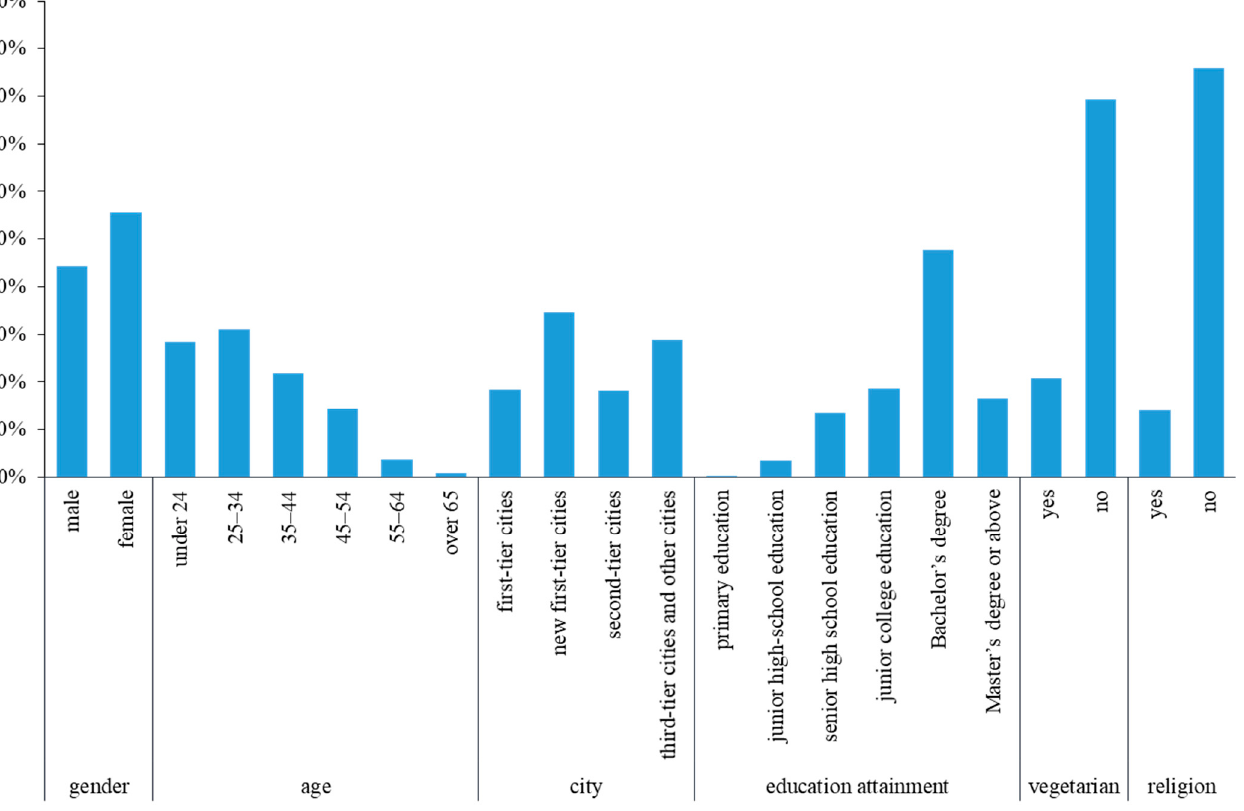
Figure 1. Demographic bar chart.